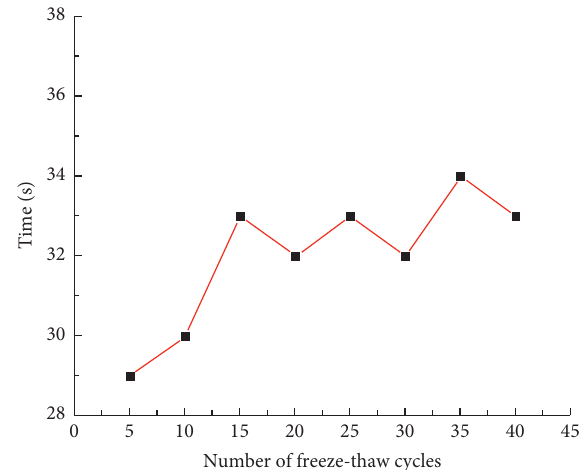
Figure 13: Time required for the ice-water phase transition phase as a function of freeze-thaw